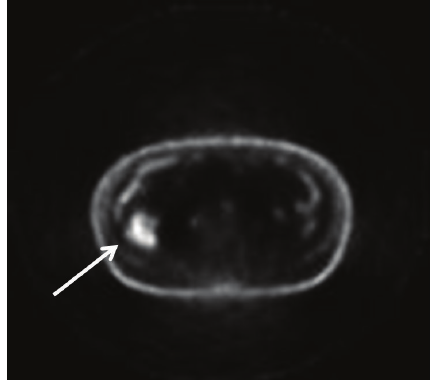
Figure 2: Positron emission tomography scan showing an area of increased tracer uptake in the right costal-phrenic angle ( arrow